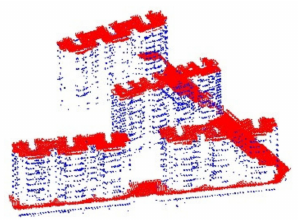
Figure 7. An illustration of region